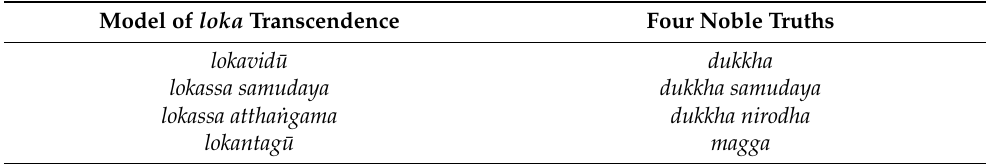
Table 1. The development of the model of the four noble truths: 1. Be aware of the existence of the world/suffering; 2. be aware of the origin of the world/suffering; 3. be aware of the end/cessation of the world/suffering; 4. be the world-ender/Follow the path to the end of suffering. Model of loka